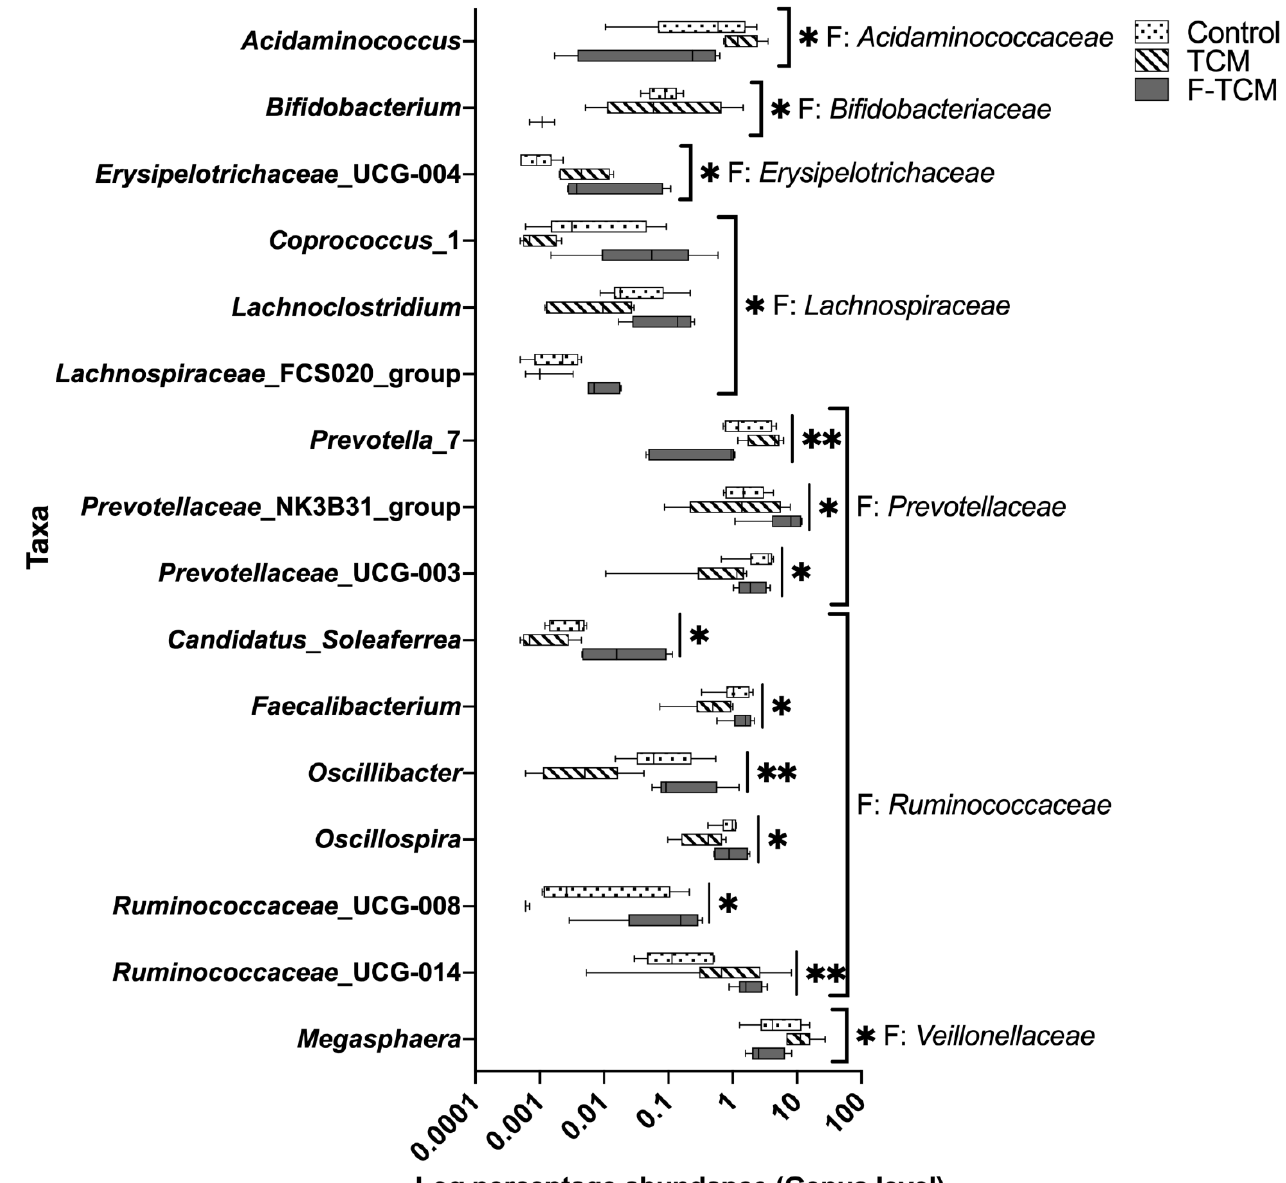
Figure 4. The relative abundance of the fecal microbiota of weaned piglets at the genus level. F: family. * indicate significant differences among three groups ( p < 0.05), ** indicate significant differences among three groups ( p < 0.01) .